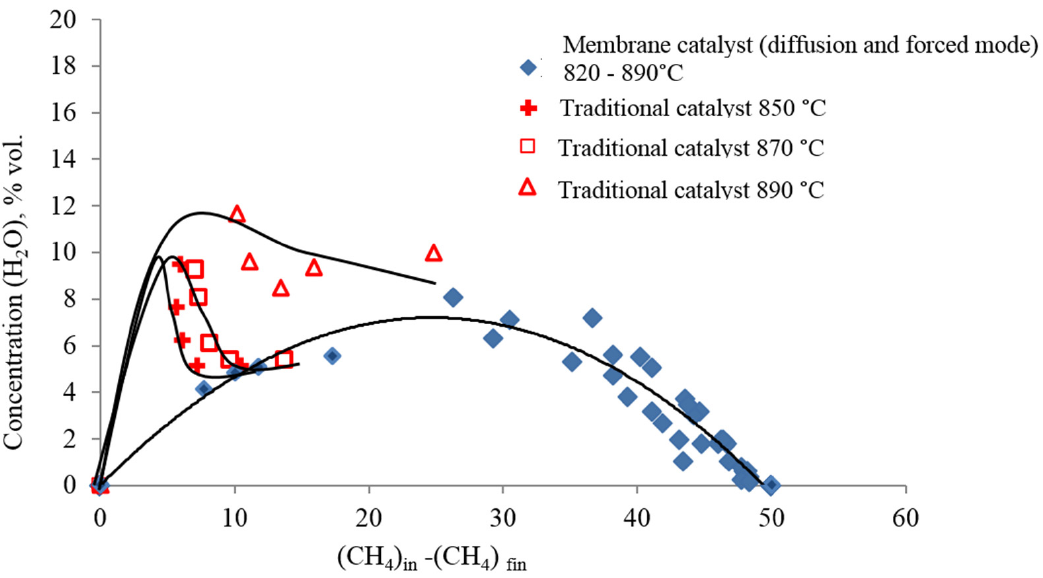
Figure 4. Dependence of the change in the concentration of H 2 O on the amount of methane that enters into the reaction on traditional and membrane catalysts, when the temperature of the DRM process changes from 850 °C to 900 °C at the TC and from 820 °C to 890 °C (at MC), and the flow rates of the reagent mixture change from 20 to 340 cm 3 (at standard)/min and from 70 to 320 cm 3 (at standard)/min, respectively).